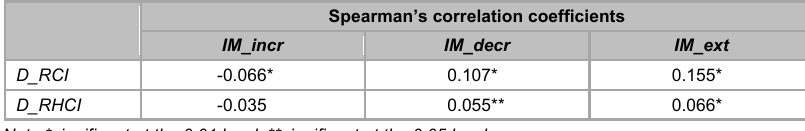
Correlation analysis of factor intensities within the intensive margin Spearman’s correlation